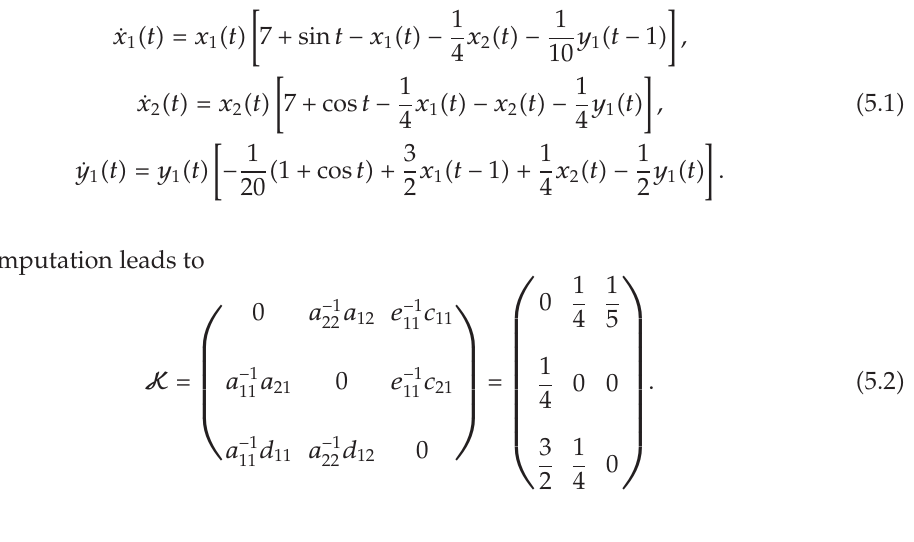
Condition (cid:4) 2.10 (cid:7) corresponds to the row norms of D K T D − 1 and note that ρ (cid:4) D K T D − 1 (cid:7) (cid:8) ρ (cid:4) D K D − 1 (cid:7) . Now Corollary 4.2 follows